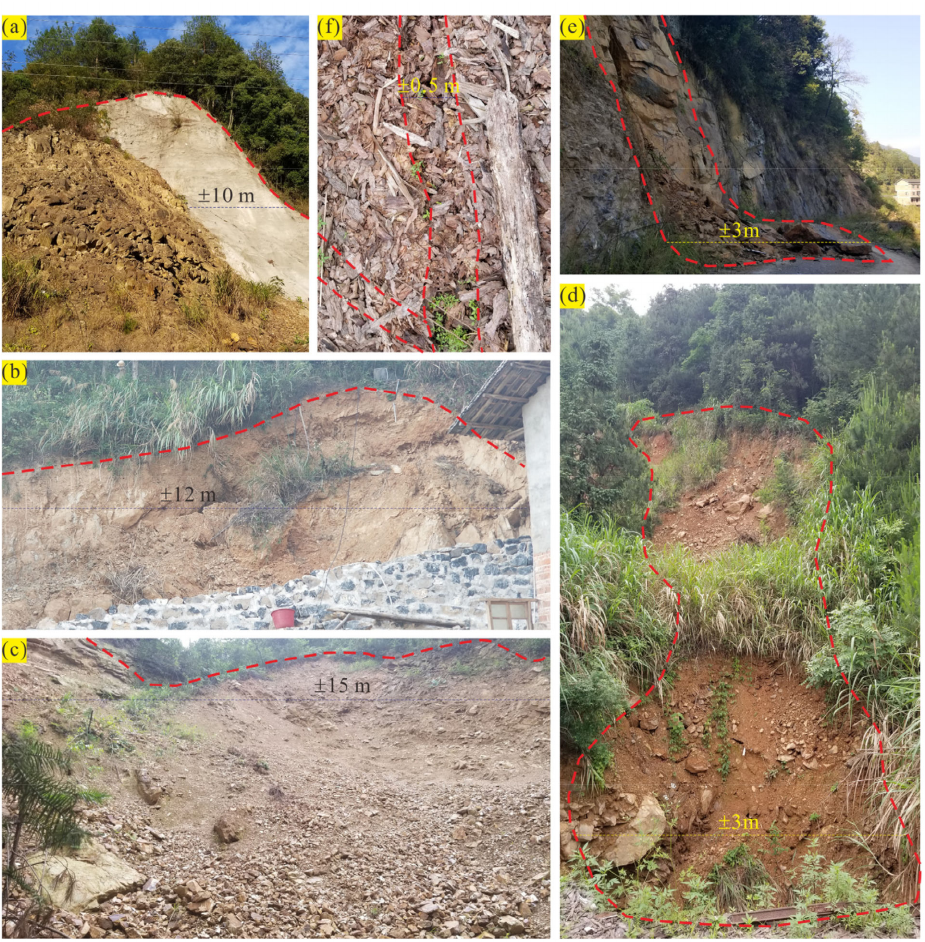
Figure 3. Mining-induced geo-disasters (MG) in the Liaojiaping Orefield, showing the different types and scales, ( a , b ): landslide, ( c , d ): subsidence, ( e ): collapse, and ( f ): ground